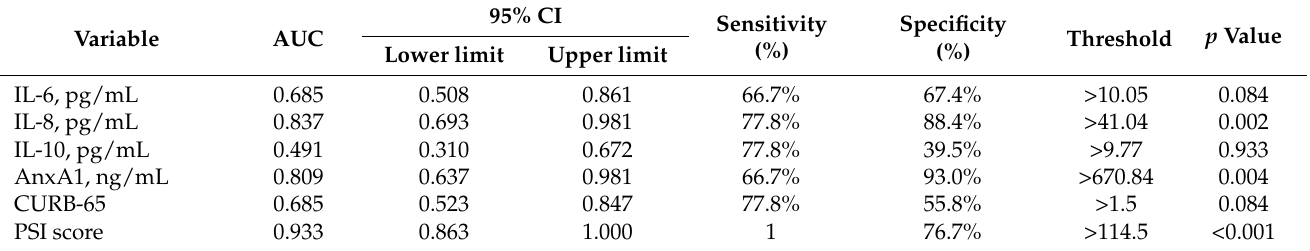
Table 5. Area under the curve and thresholds for predicting 30-day mortality in CAP patients.